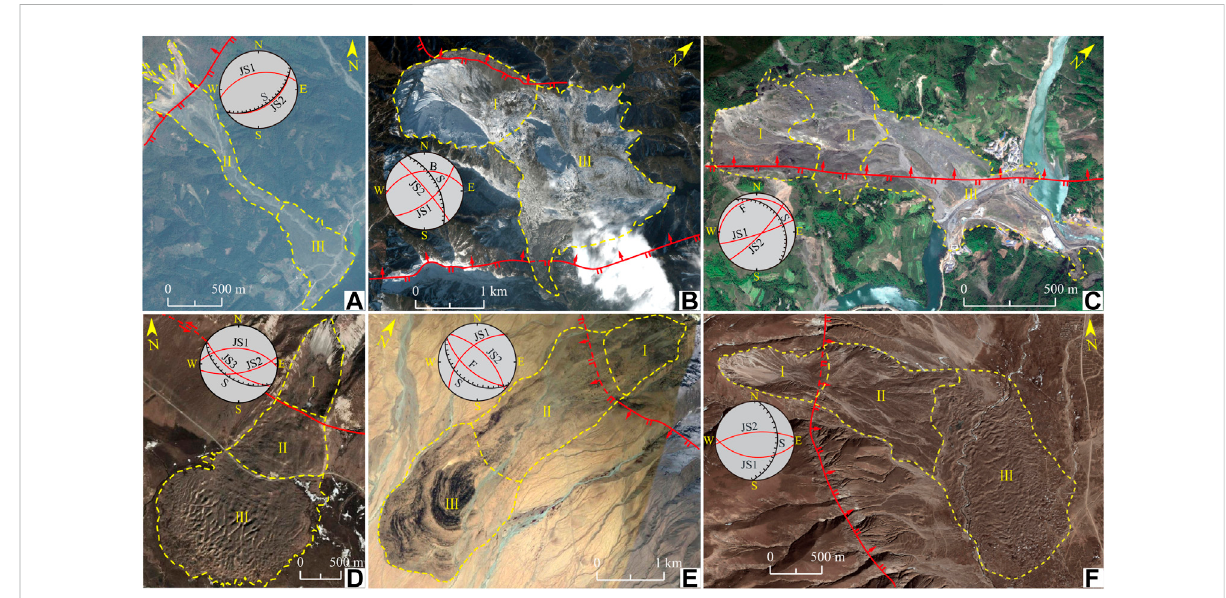
FIGURE 2 Remote images of the Xiejiadianzi (A) , Daguangbao (B) , Donghekou (C) , Luanshibao (D) , Tagarma (E) , and Nyixoi Chongco (F) rock avalanches with the stereographic projections of their source area preferred structures. JS, joints; F, foliation; S, slope; B, bedding plane; I: source area; II: transition zone; III: accumulation